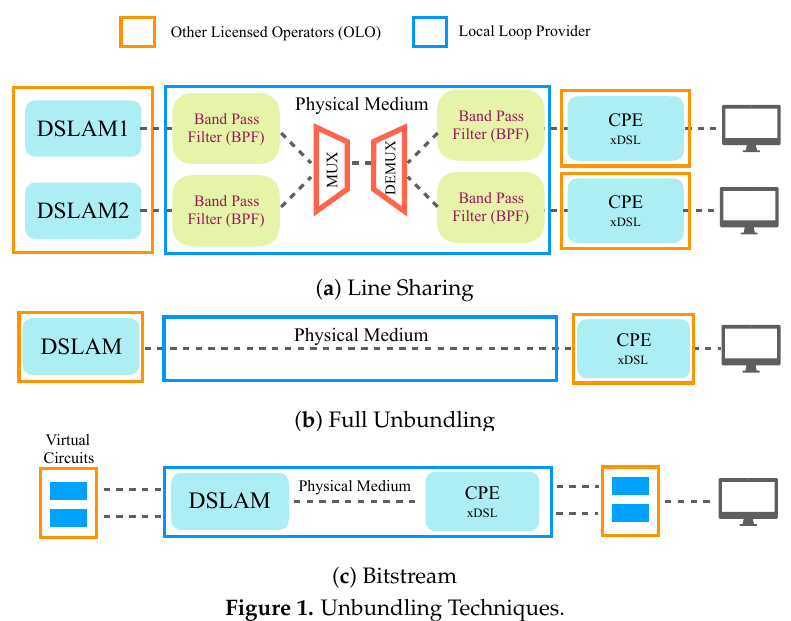
Figure 1. Unbundling